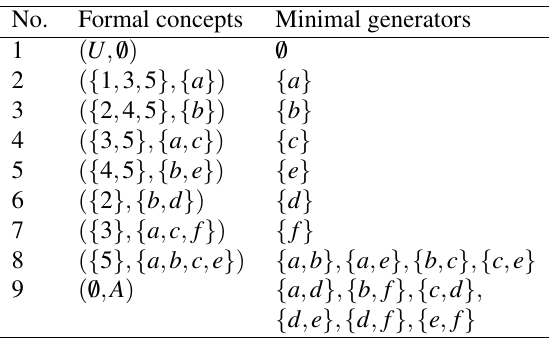
Table 2. Minimal generators of all formal concepts of ( U , A , I )